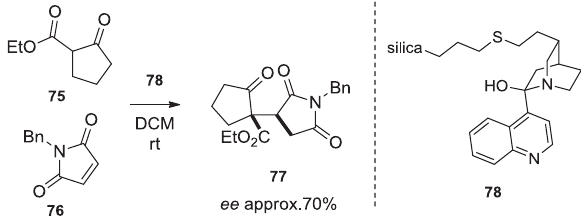
Figure 19. Enantioselective Michael addition, from Ref.